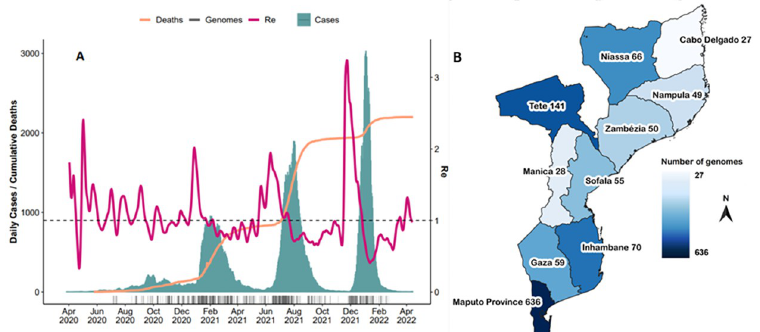
Fig 2. SARS-CoV-2 epidemiological dynamics in Mozambique. (A) Schematic illustration of genomic and epidemiological data. Changes in the daily reported COVID-19 cases are indicated in blue, the cumulative death count associated with COVID-19 disease in orange, and the estimated Re values are indicated in purple. (B) Geographic map of Mozambique illustrating the origin and count genome sequences generated in this study (The map for Mozambique was accessed using the software packages used for mapping, GADM, https://gadm.org/download_country.html). Genome sequences without information on the province from which it originated were omitted from this graph.